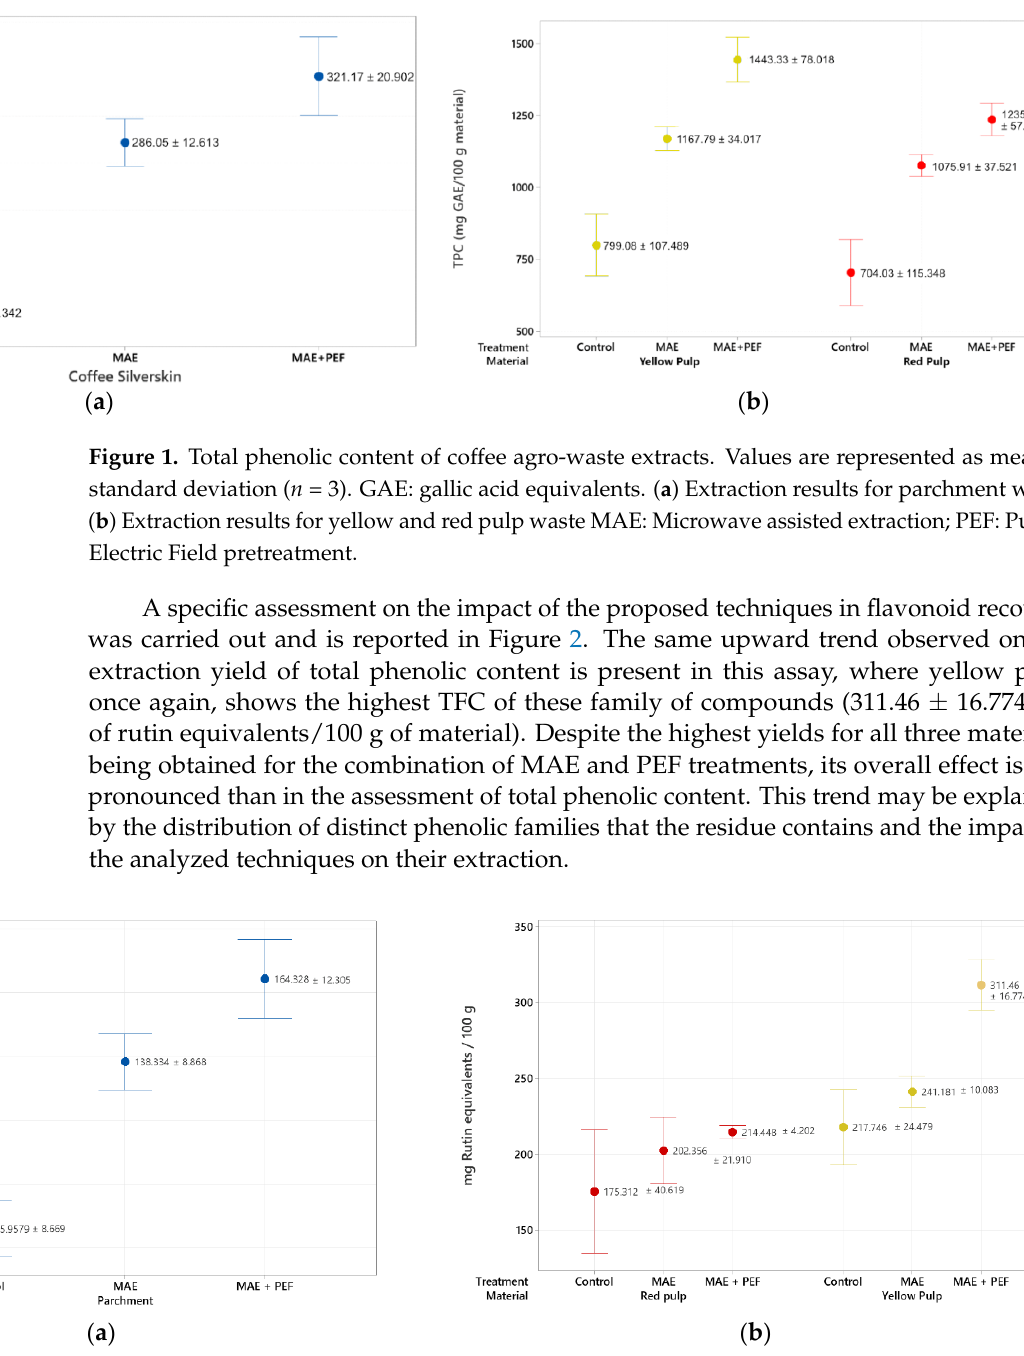
Figure 2. Total flavonoid content of coffee agro-waste extracts. Values are represented as mean ± standard deviation ( n = 3). ( a ) Extraction results for parchment waste. ( b ) Extraction results for yellow and red pulp waste MAE: Microwave assisted extraction; PEF: Pulsed Electric Field pretreat- ment.